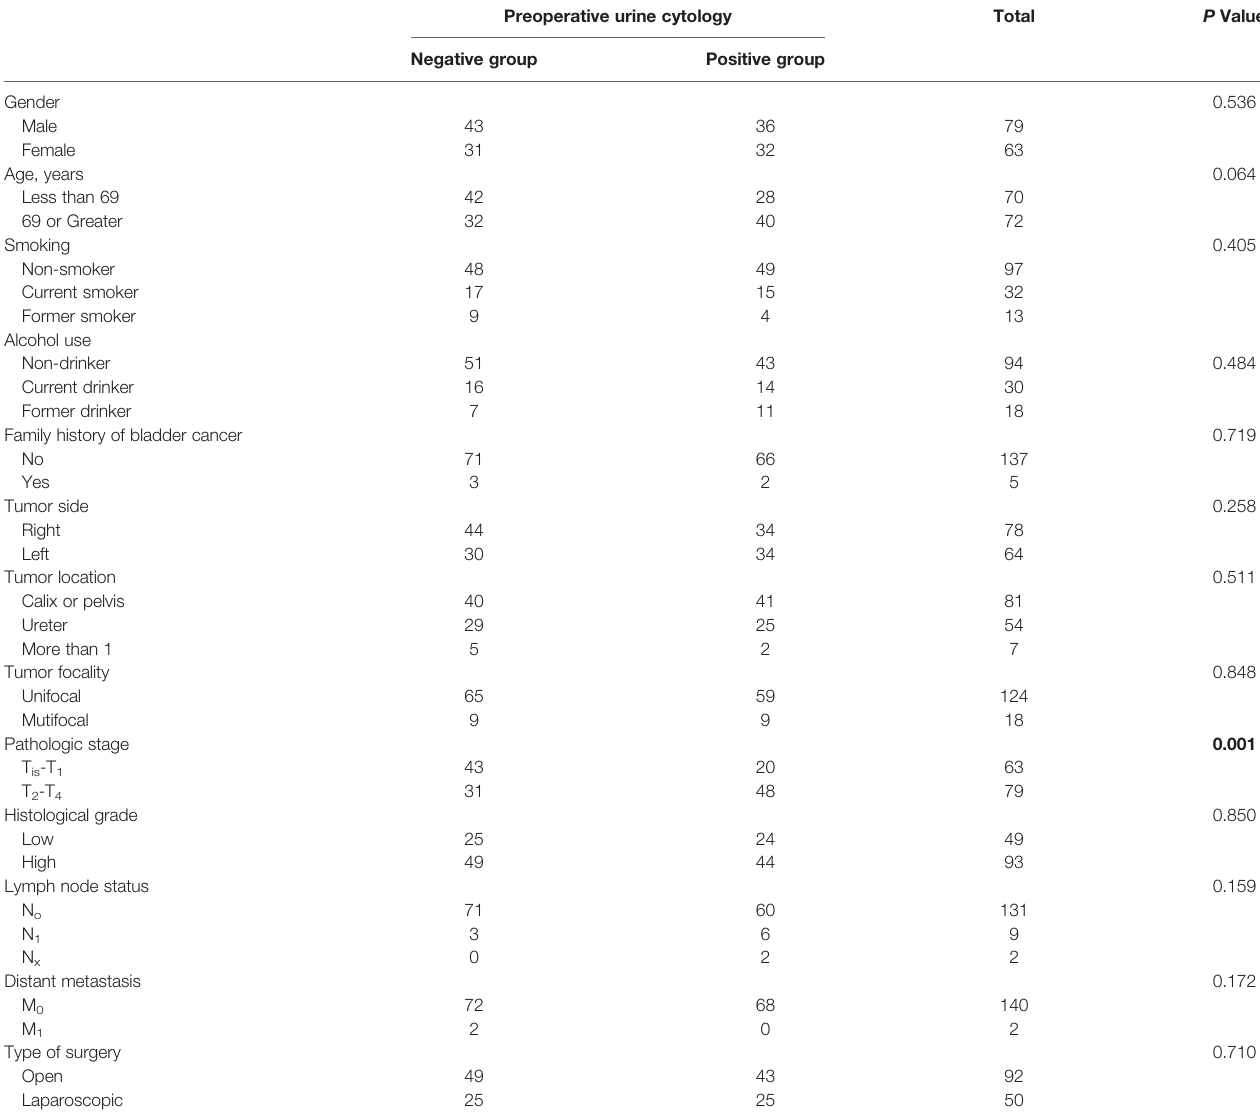
TABLE 1 | Demographics and clinicopathologic characteristics of 142 patients treated with RNU for UUT-UC in training cohort. Preoperative urine